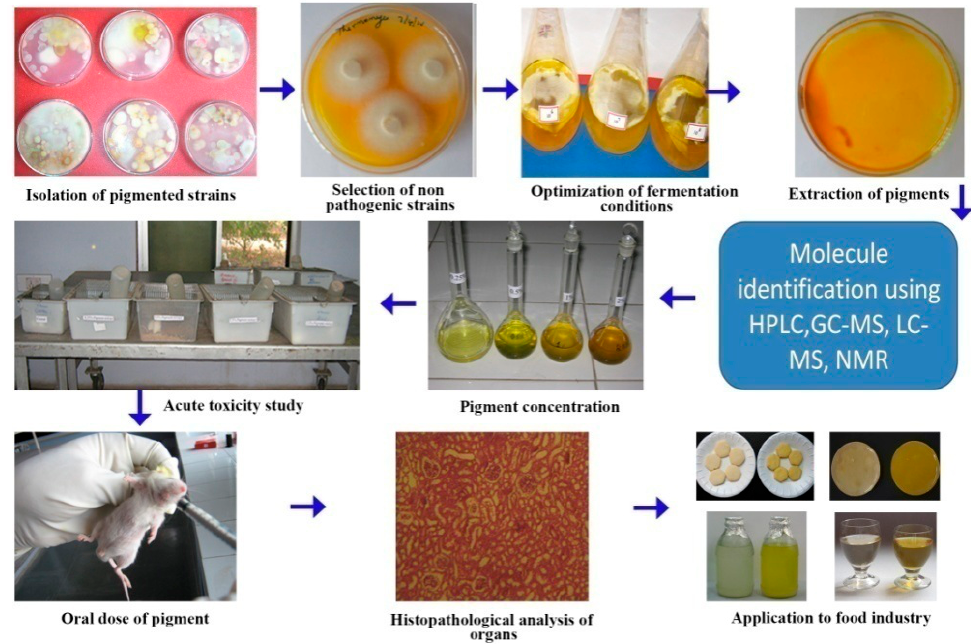
Figure 3. Toxicity evaluation of Thermomyces sp. pigment using an animal model.